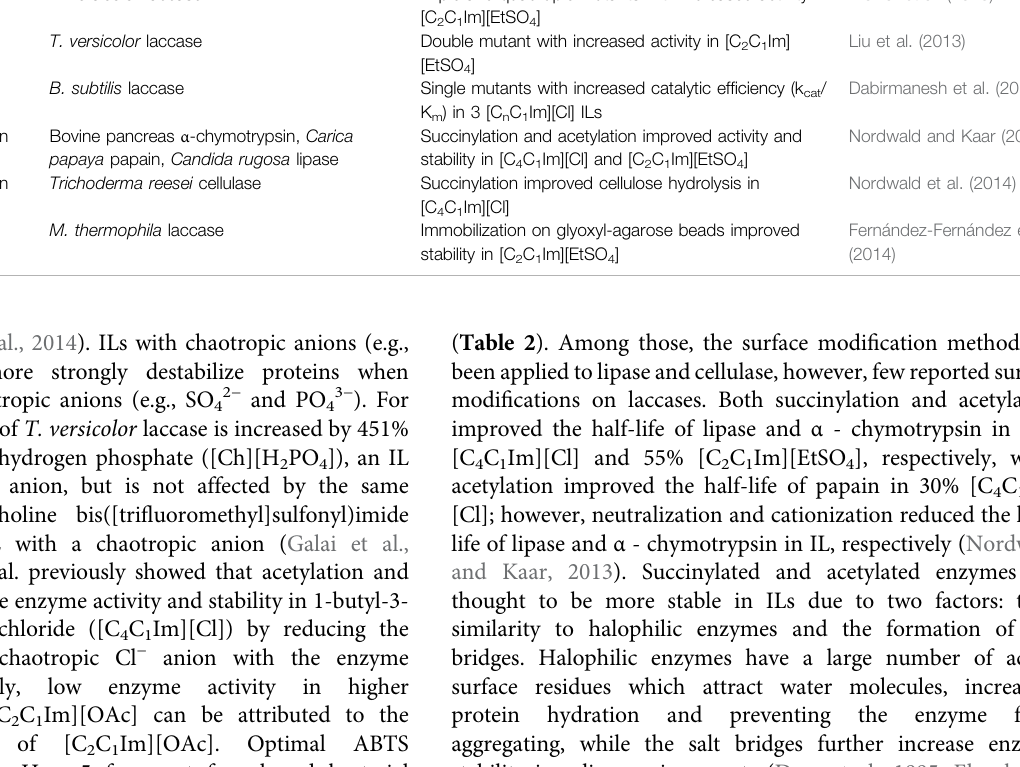
TABLE 2 | Previous studies using various methods to improve enzyme activity in